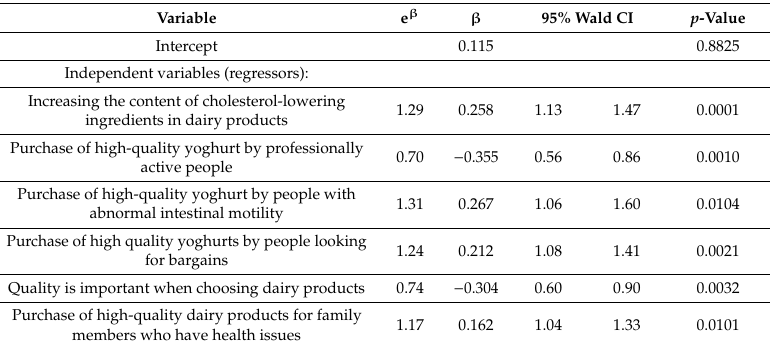
Table 9. Prediction of acceptance of enhancing food products with health-promoting ingredients at the processing stage. Variable e β β 95% Wald CI p -Value Intercept 0.115